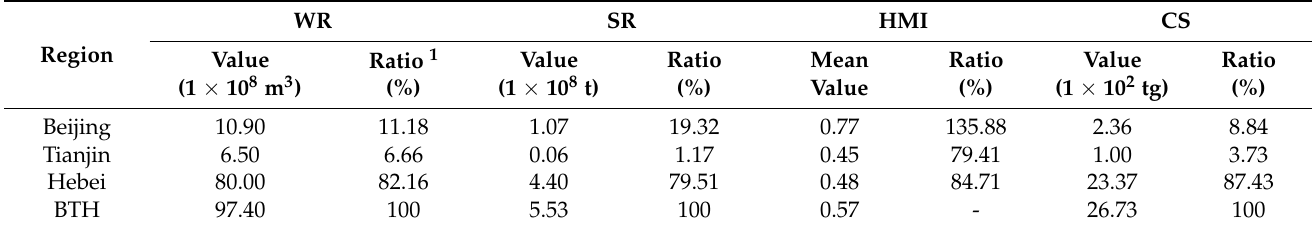
Figure 3. Spatial distribution of ecosystem services at the county level in the BTH region, including Table 1. Statistics of the modeling results of ecosystem services in the BTH